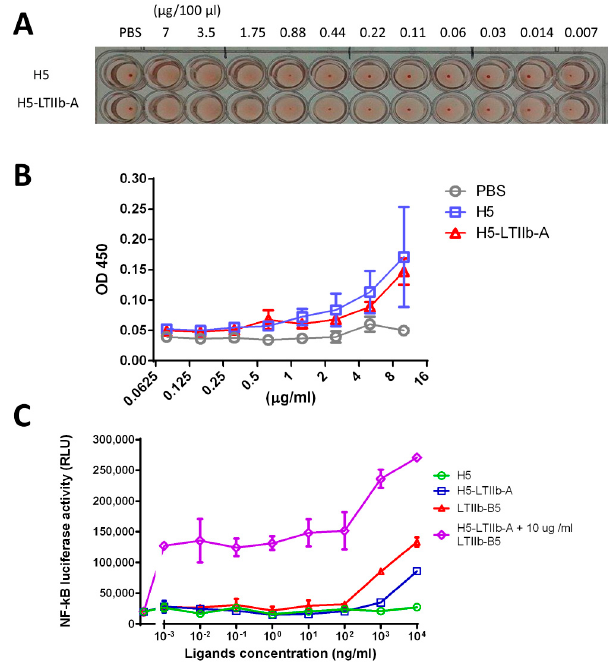
Figure 2. ( A ) Comparison of hemagglutination due to the recombinant H5 protein or the H5-LTIIb-A fusion protein by using hemagglutination assay; ( B ) fetuin binding capability of the recombinant H5 protein and the H5-LTIIb-A fusion protein by using fetuin binding assay; ( C ) detection of the TLR2/1 and NF- κ B activation by various protein samples using TLR2/1 functional assay; the various protein samples include the recombinant H5 protein, the H5-LTIIb-A fusion protein, a recombinant protein of E. coli type IIb heat-labile enterotoxin B subunit (LTIIb-B5), and the combination of the H5-LTIIb-A fusion protein and 10 4 ng / ml of the recombinant LTIIb-B5 protein (denoted as H5-LTIIb-A + 10 µ g / ml